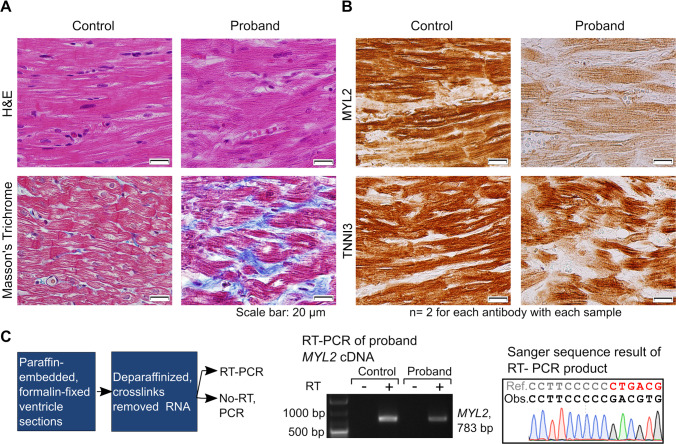
Analysis of the ventricular myocardium of the proband shows characteristic features of hypertrophic cardiomyopathy (HCM) and molecular consequences of the variant.(A) Histochemical analysis of the ventricular myocardium from the proband by H&E staining shows myocyte disarray as compared to control. Masson’s trichrome staining of the proband’s ventricular myocardium shows increased fibrosis (stained with blue). (B) Immunohistochemical analysis of MYL2 expression in the proband’s ventricular myocardium shows a remarkable reduction in the expression of MYL2 as compared to control. The antibody used targets residues at the N-terminal region of the protein (S4 Fig). Cardiac troponin I (TNNI3) was detected at comparable levels in the control and the proband myocardium. The unstained areas correspond to fibrosis. (C) Flow diagram showing the steps used to analyze MYL2 mRNA expression in the ventricular myocardium of the proband. An RT-PCR product of the expected size of MYL2 mRNA is detected in the control and proband tissue, and not in the negative (No-RT) controls. Sanger sequencing of the product from the proband shows the MYL2 mRNA transcript with the dinucleotide deletion.